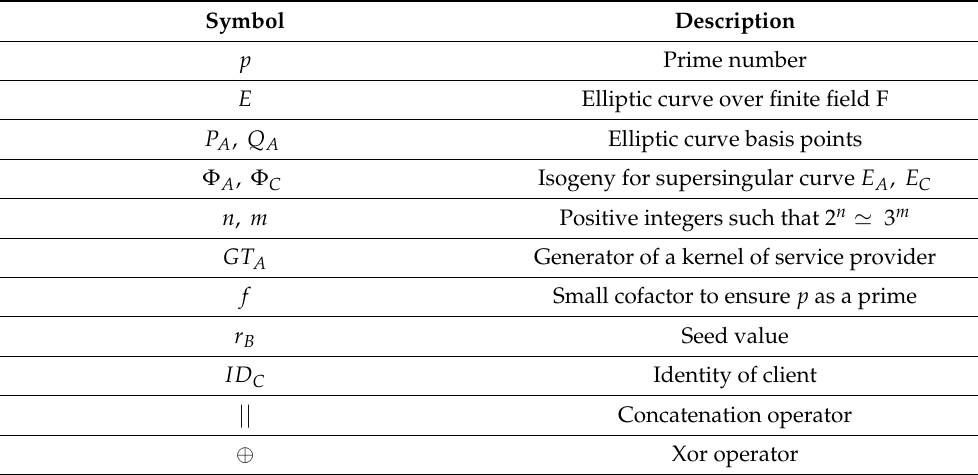
Table 1. Nomenclature. Symbol Description p Prime number E Elliptic curve over finite field